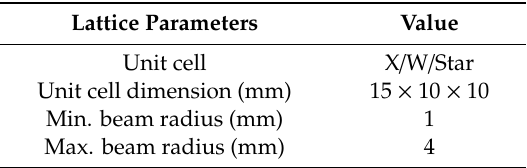
Figure 7. Identification of region for lattice introduction by using: ( a ) the isolines of the hotspot volume in printing, ( b ) the von Mises stress buildup in the part during printing, ( c ) the von Mises stress experienced by the optimized cantilever part during static loading and ( d ) the manufacturing constraints of minimum overhang angle and clearance from the base to create ( e ) the partitioned domain. The dotted arrows indicate the region to be considered for lattice introduction. Continuous black lines are fixed. Dotted black lines can be adjusted to accommodate the changing parameters for a given setup (e.g., varying hotspot buildup (a) for the same part using di ff erent process parameters or di ff erent allowable overhang angles for di ff erent selective laser melting (SLM) machines (d)). The volume of the region was 44,141 mm 3 and the mass being replaced was 0.19 kg which gave an e ff ective density of the lattice region to be around 0.0041 g / mm 3 . The angle of the struts is critical for accurate and supportless manufacturing. Lattice-types considered for this purpose are the ‘X’, ‘W’ and ‘star’ (Table 2) as these lattice unit cells within the Netfabb suite can be modified to be manufactured without any supports. Table 2. Lattice optimization parameters with respect to the unit cell